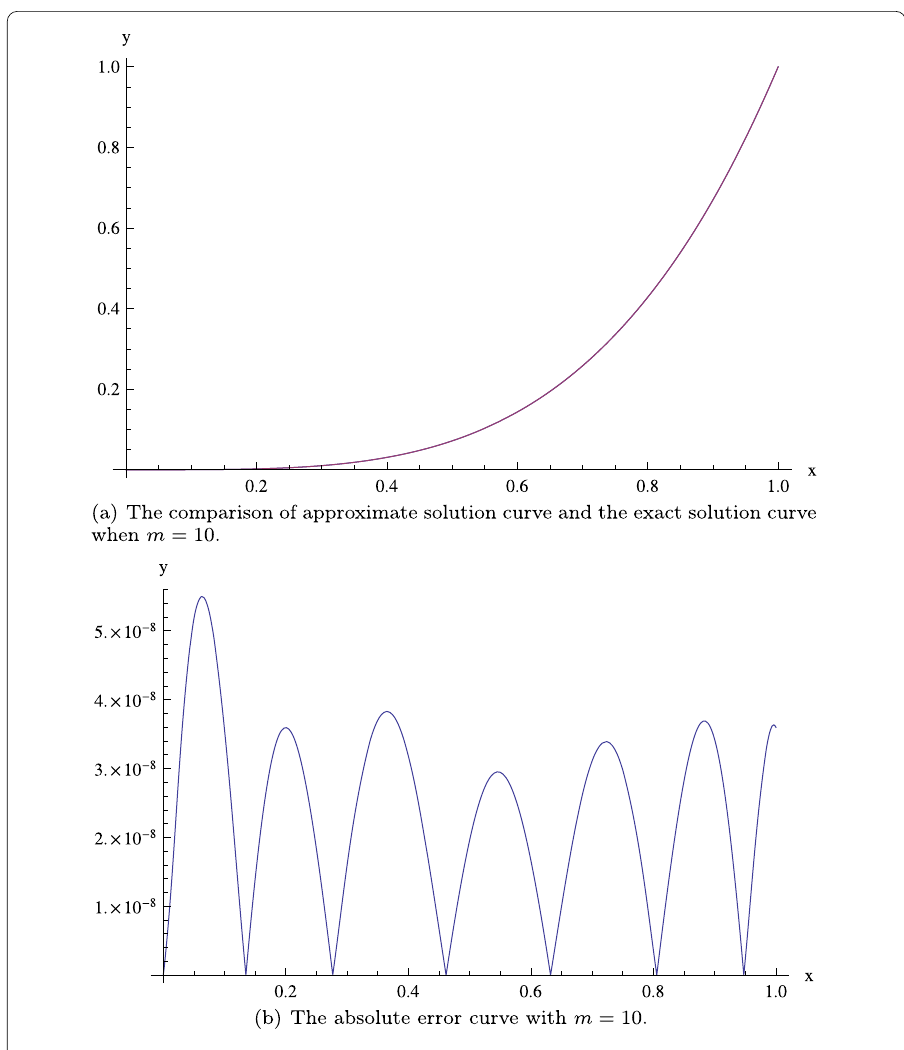
Figure 3 The comparison of the approximate solution and the exact solution when m =